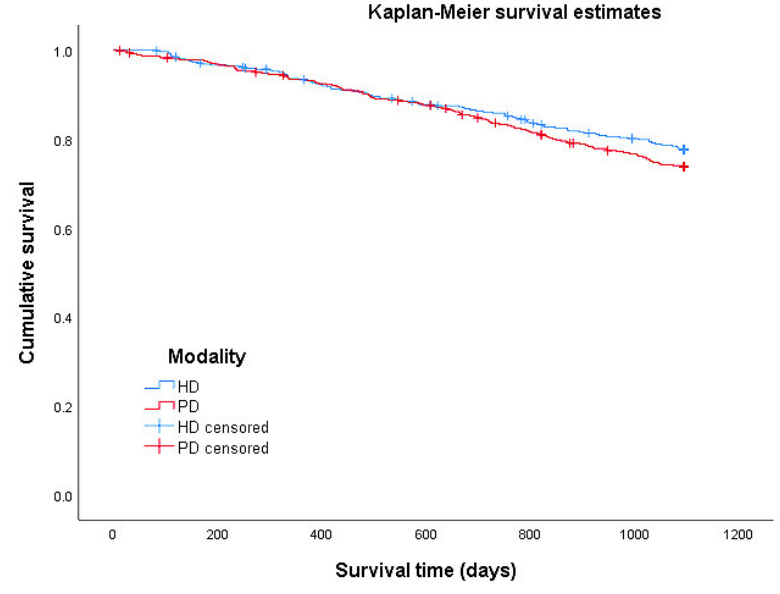
Figure 2. Overall survival (HD: n = 436, PD: n = 436, log-rank = 0.207). For comparison with the unmatched dataset see Supplementary Materials, Figure S1.